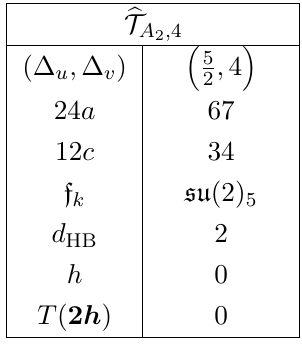
Figure 40. Information about the b T A